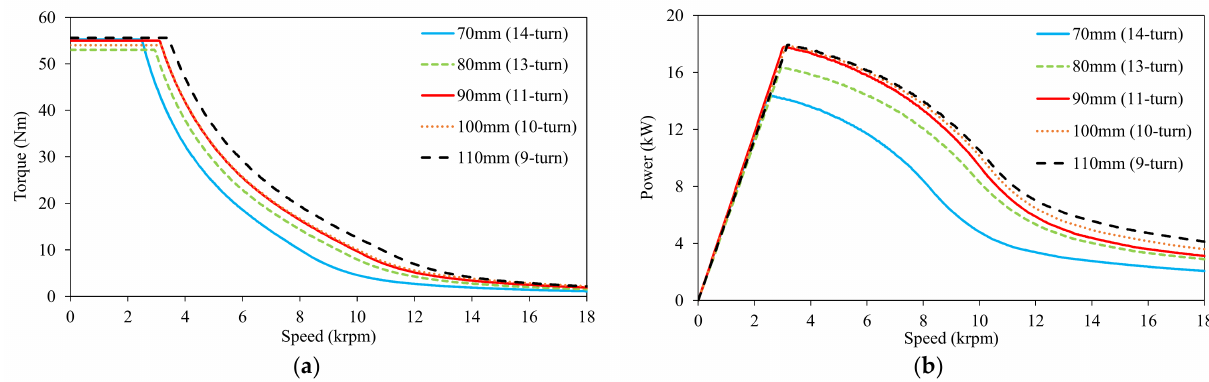
Figure 31. Variation of copper loss and efficiency with the stack length.